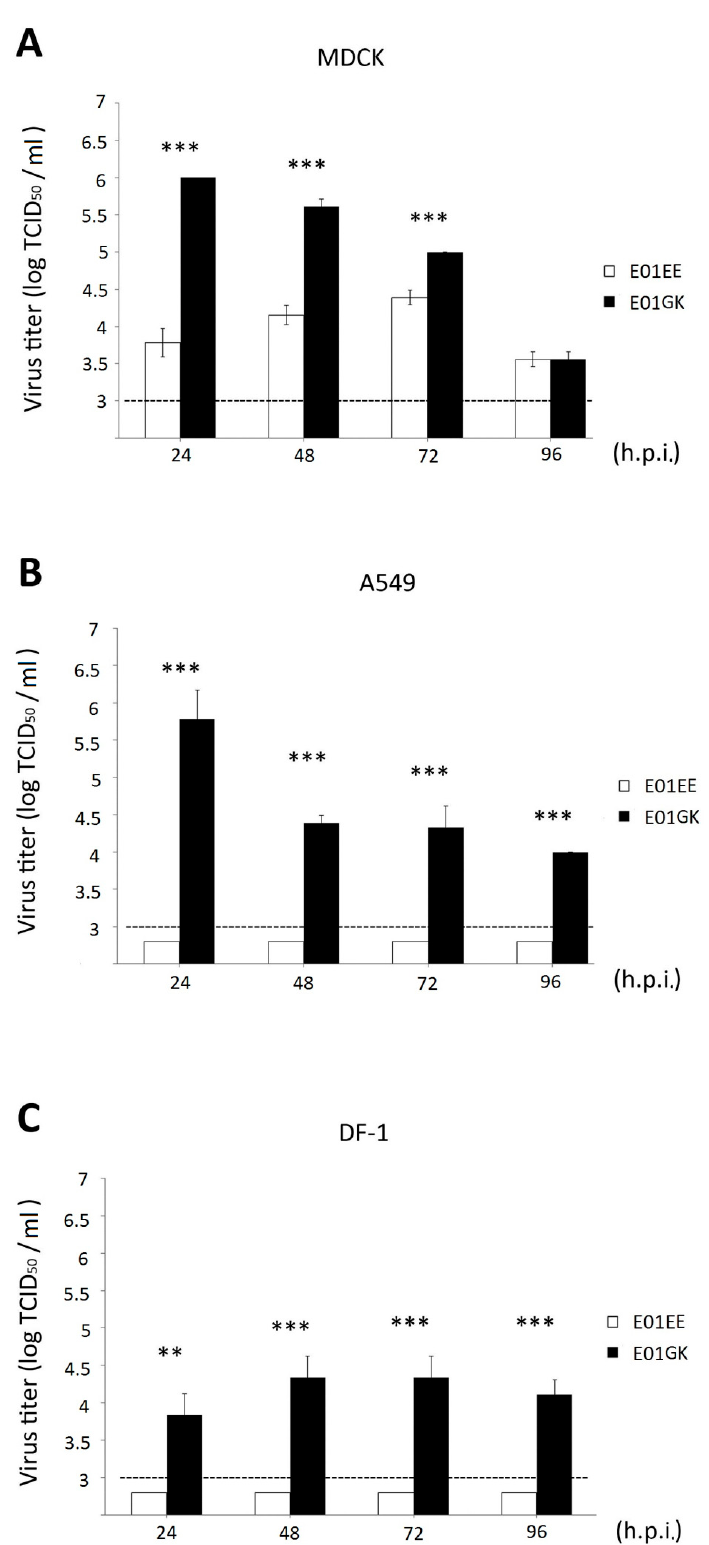
Figure 1. The viral dynamics of Madin–Darby canine kidney (MDCK) ( A ), A549 ( B ) and DF-1 cells ( C ). The cells were infected with 0.01 MOI of viruses for 1 h. The culture supernatants were collected at 24-h intervals until 96 h for viral TCID 50 measurement on MDCK cells. The lowest detectable titer is 10 3 TCID 50 / mL. h.p.i.: hours post infection. **: p < 0.01, ***: p < 0.001.